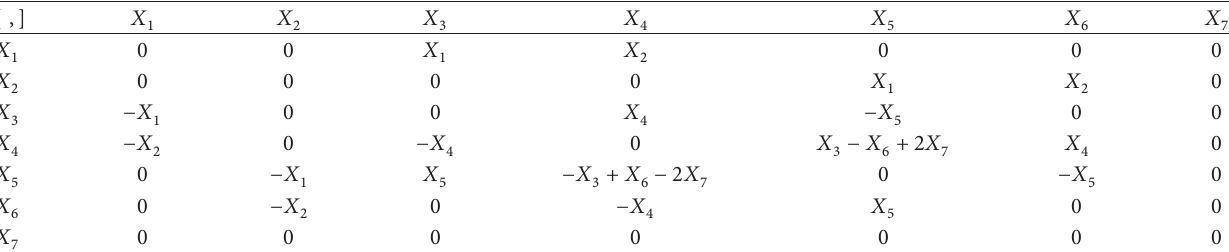
Table 1: The commutator table of g .